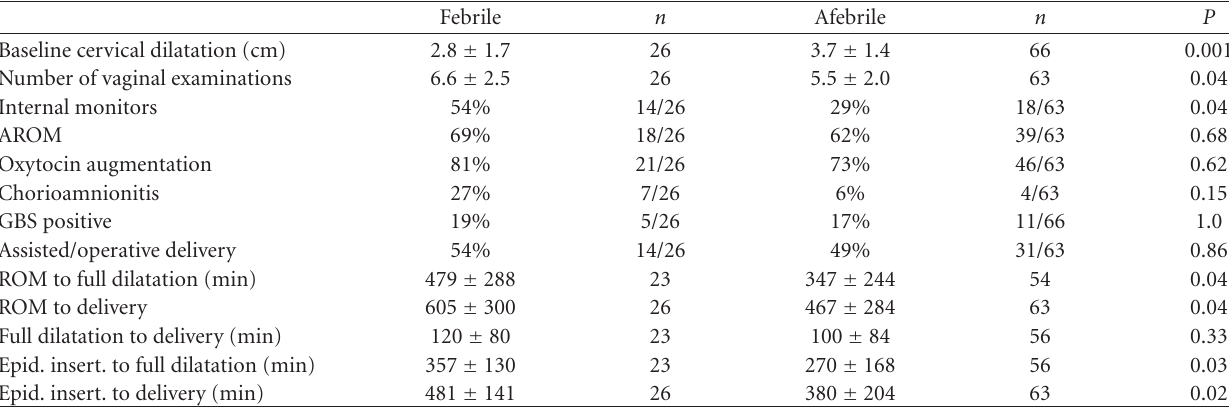
Table 3: Labor and epidural characteristics of febrile and afebrile subjects.